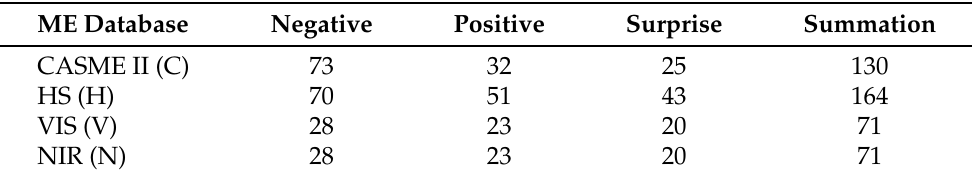
Table 1. Sample Statistics of the CASME II and SMIC databases used in the designed cross-database MER